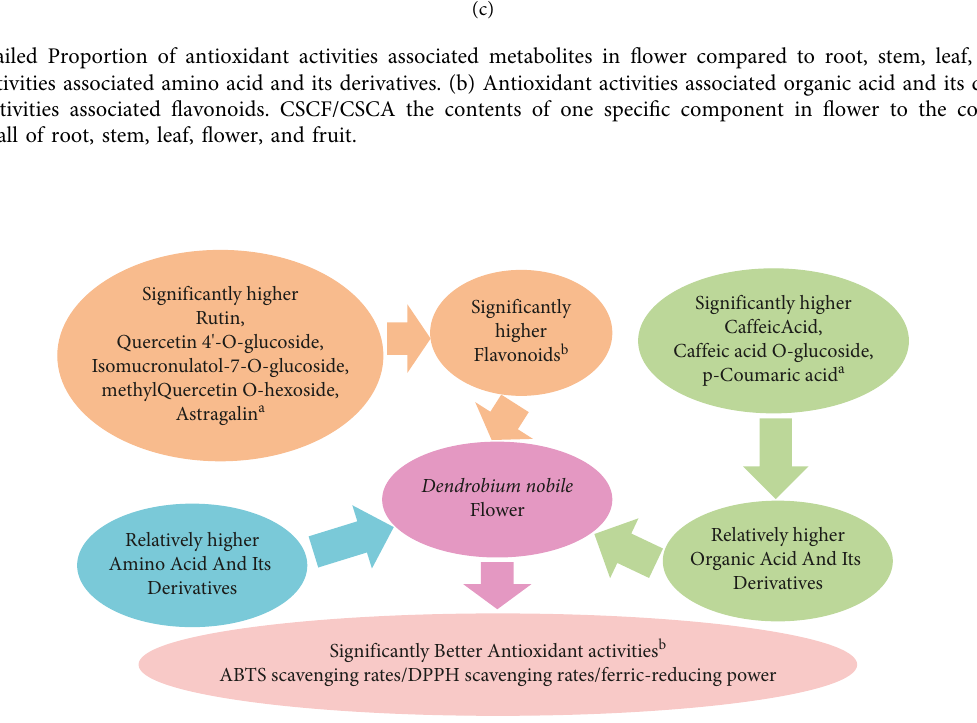
Figure 8: Diagram for antioxidant basis of D. nobile flower. a p < 0 . 01, more than 5% of relative distribution in antioxidant activities associated metabolites in flower of D . nobile , and more than 80% of CSCF/CSCA in flower compared to root, stem, leaf, and fruit b p < 0 . 05.